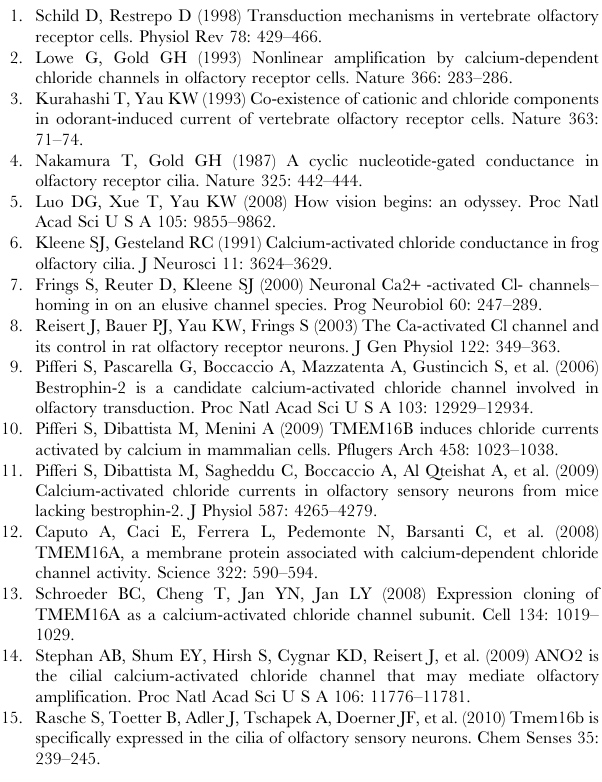
Table S2 Information on specific nested primers for ClCa2 and ClCa4l (Fig. 2). The table shows the sequence of the specific ClCa2 and ClCa4l nested primers. Table S3 Primer information for PCR used to deter- mine the full sequence of the olfactory ClCa transcript. The table shows information on the seven pairs of primers used to Table S4 Information on specific primers for ANO1 and ANO2 (Fig. S2). The table shows the sequence of the specific ANO1 (GeneID: 309135) and ANO2 (GeneID: 243634)